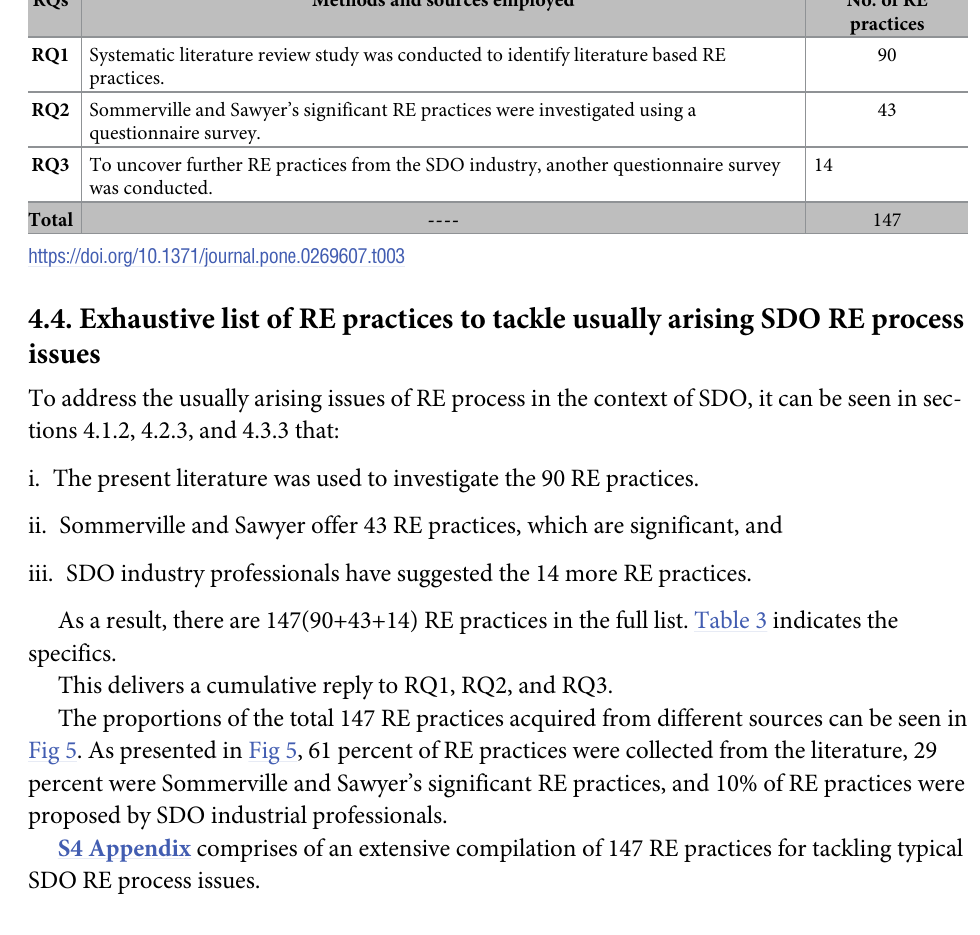
Table 3. No. of identified RE practices to tackle SDO RE process issues. RQs